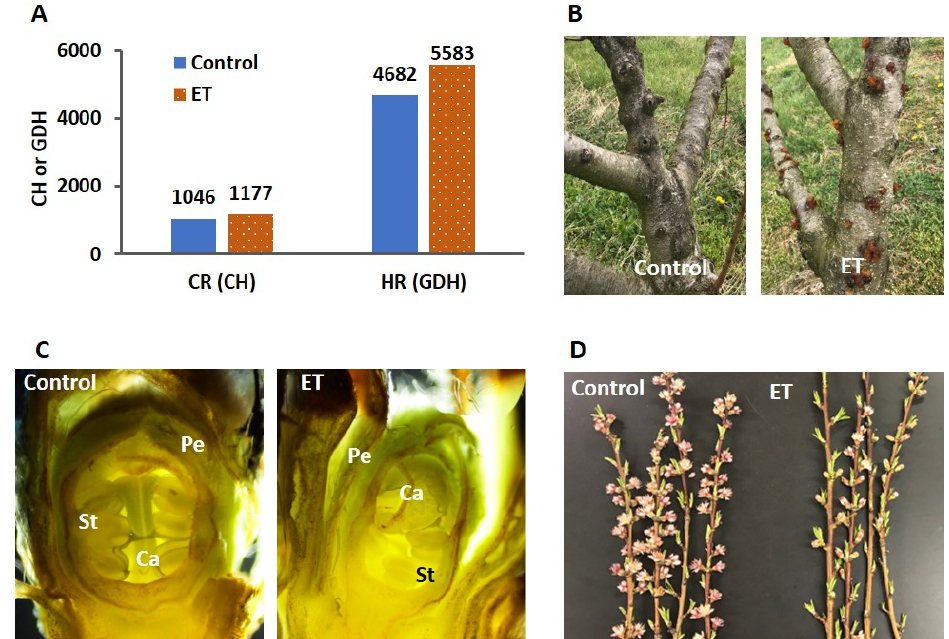
Figure 1. Phenotypical characterization of the ET treatment on dormant peach buds. ( A ) Chilling requirement (CR) and heat requirement (HR) of the control and the ET treatment. ( B ) Comparison of gummosis incidence on the tree barks of the ET treatment and the control. ( C ) Dissection of dormant floral buds from the control and the ET treatment at 1100 CH, showing petal (Pe), stamen (St), and carpel (Ca). ( D ) Bloom of the control and the ET treatment on 30 March 2020. CH, chilling hour; GDH, growing degree hour; ET, ethephon.